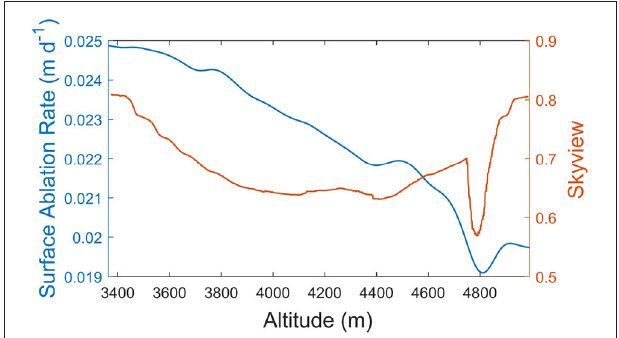
FIGURE 2 | Topographic shading effect on the simulated surface ablation rates for the Baltoro Glacier in 2004. The ablation rates are averaged over 30 m altitude bins. The skyview factor represents the topographic shielding that governs the diffuse-skylight irradiance. The abrupt drop in the skyview is associated with the minimum ablation along the profile, which highlights this meso-scale topographic effect on glacier surface